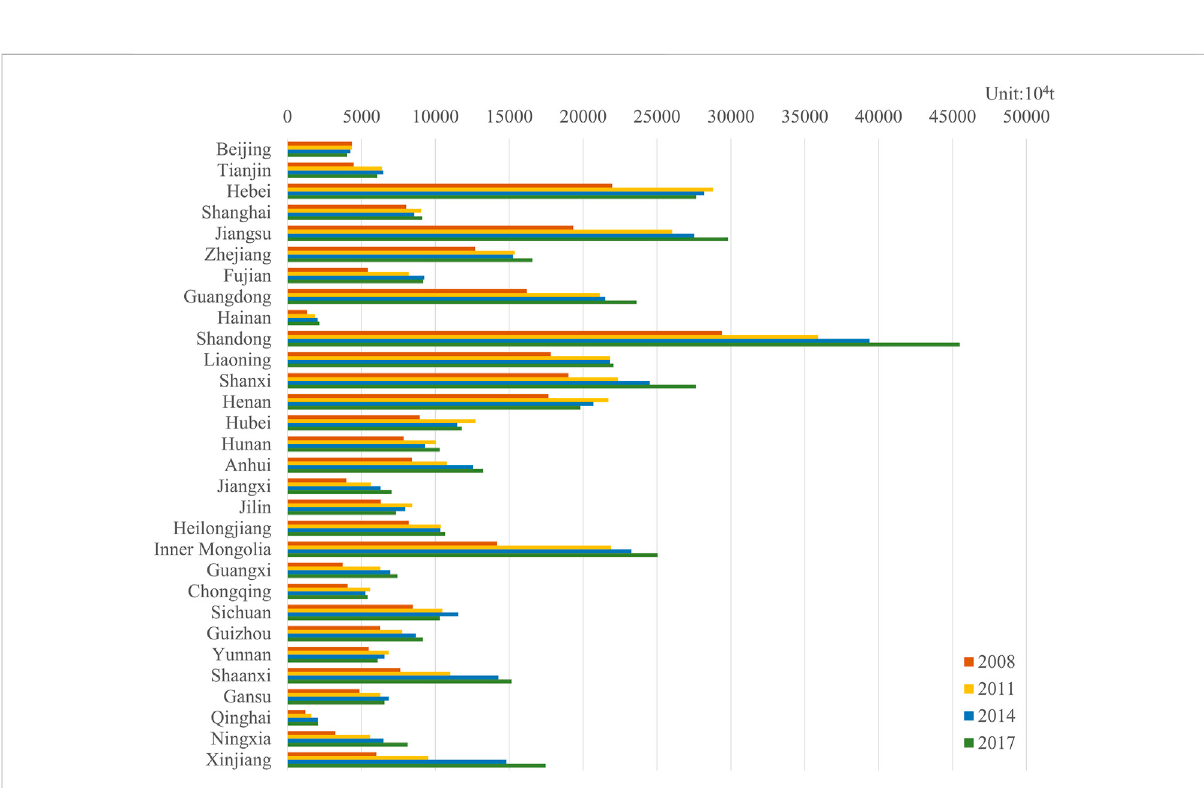
FIGURE 3 Carbon emissions of China ’ s provinces from 2008 to